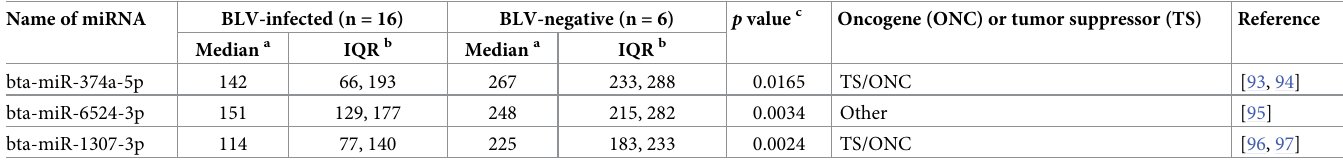
negative correlation coefficients (-0.7 < r < -0.6, p < 0.05). Only bta-miR-375-3p had a signifi- cant positive correlation ( r = 0.565, p = 0.0249) with PVL (Fig 2G, Table 4). When bta-miR- 375 expression was compared among BLV-uninfected, BLV-infected, and cattle with EBL via quantitative RT-PCR, the levels were significantly higher in EBL cattle than in BLV-uninfected and BLV-infected cattle (BLV-uninfected vs EBL, p = 0.0096; BLV-infected vs EBL, p = 0.0245) (Fig 2H).